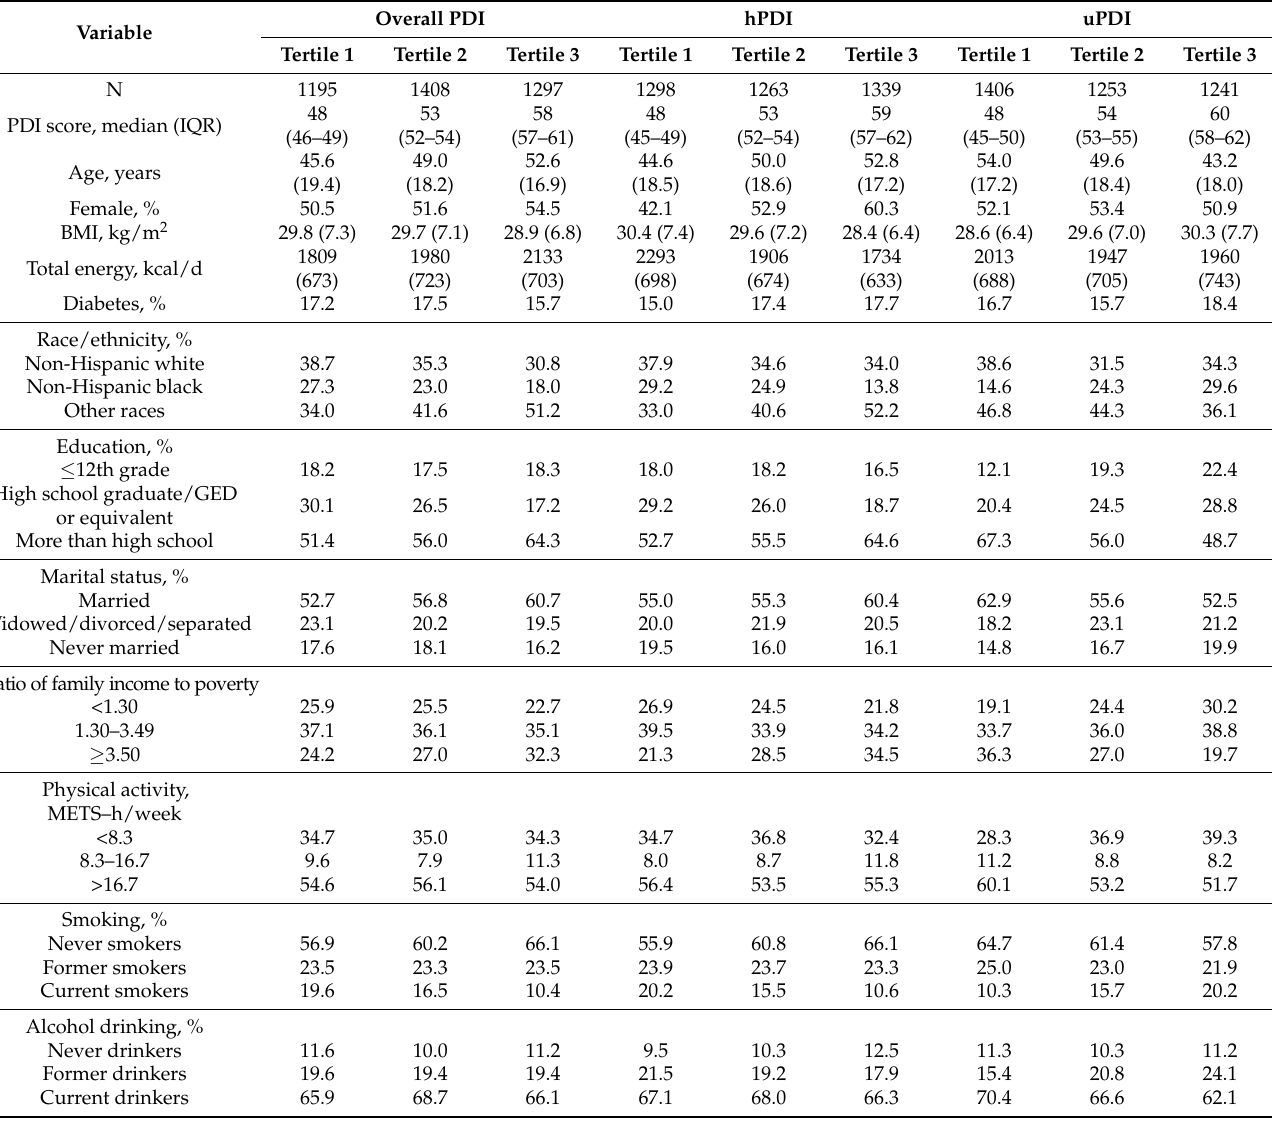
Table 1. Age-adjusted characteristics of participants based on the tertiles of PDIs a